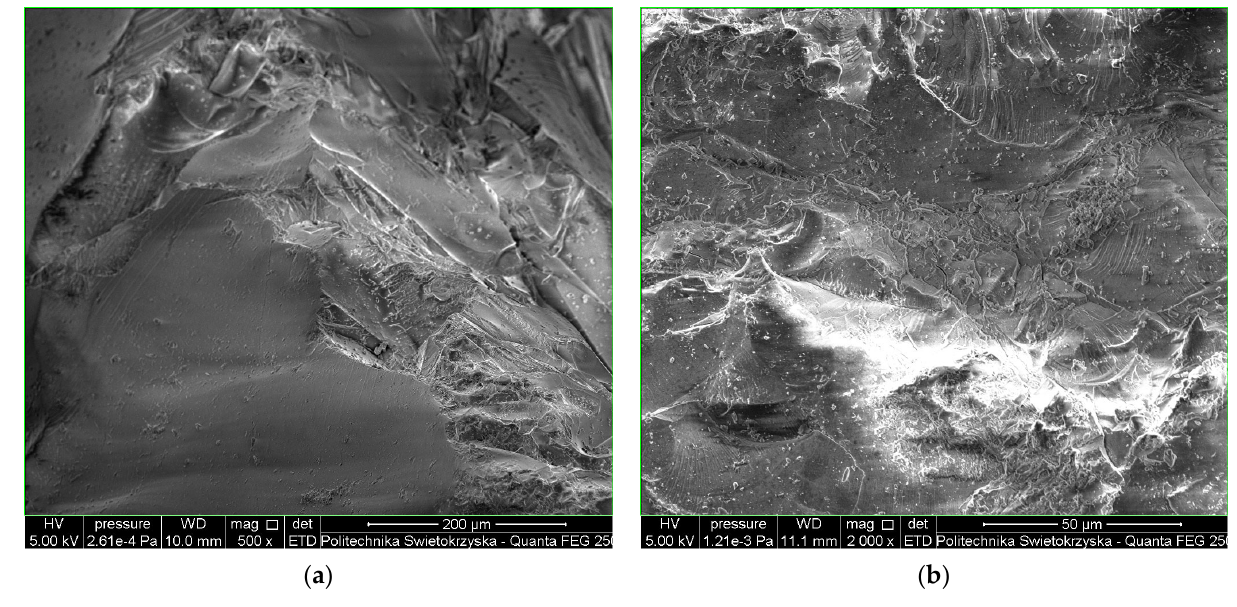
Figure 1. Examples of glass microstructure from recycled bottles observed under a scanning elec ‐ tron microscope (SEM); ( a ) colorless bottle glass, 200 μ m magnification; ( b ) white bottle glass, 50 μ m magnification.